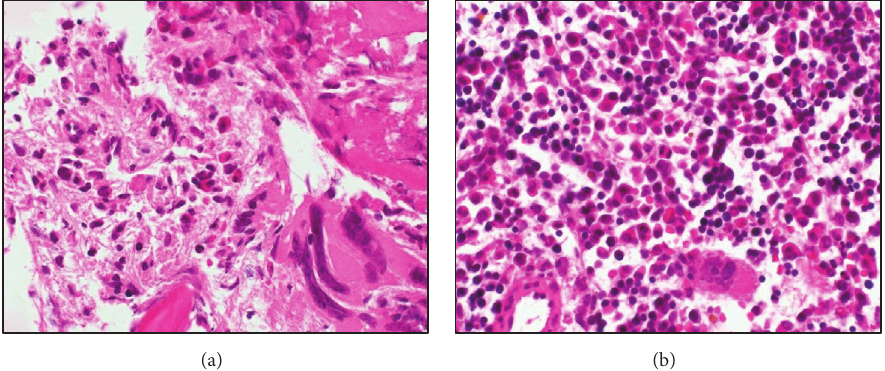
Figure 4: Case 2. Histology of bone marrow (HE stain). (a) Before HCT, the bone marrow biopsy showed secondary MF. (b) After HCT, the marrow specimen showed that the fibrosis regressed, and the morphological abnormalities in megakaryocytes had